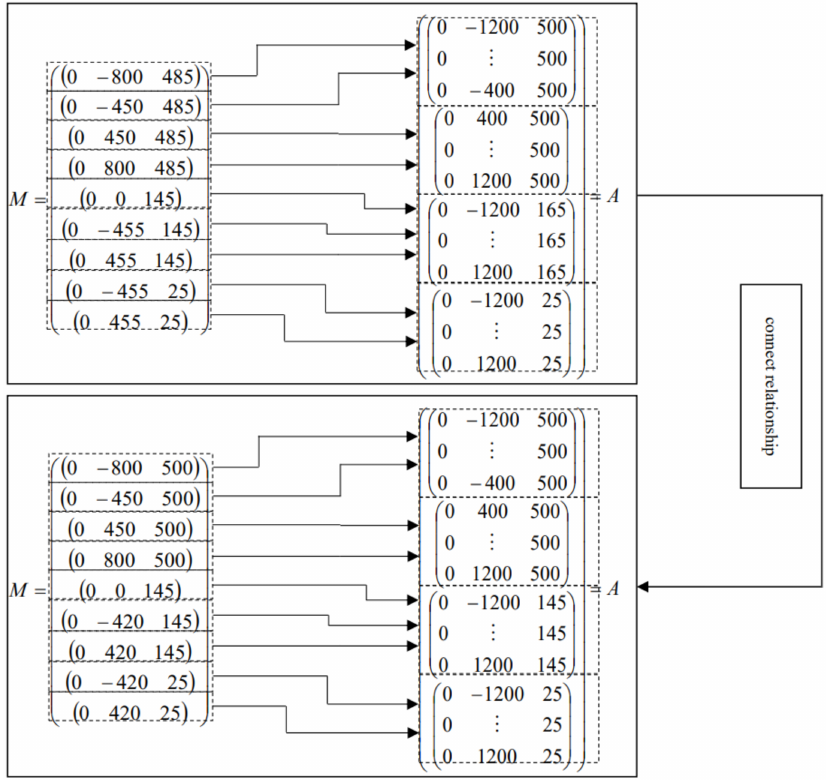
Figure 14. Confirmation of connection relationships between modules and module